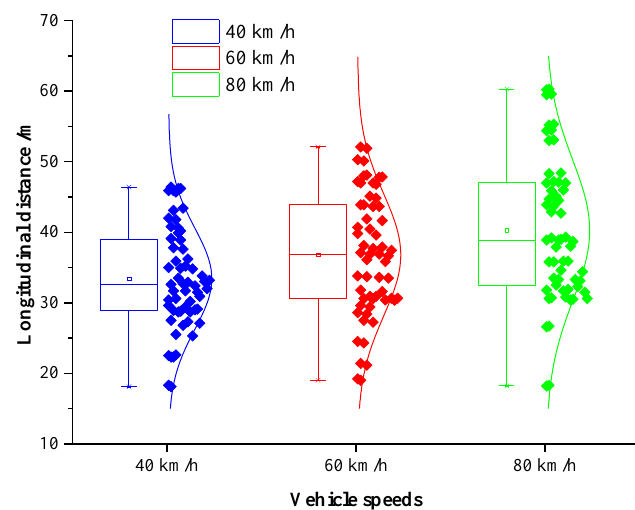
Figure12. Boxdiagramofthelongitudinaldistanceatthebeginningofavoidanceunderdi ff Figure 12. Box diagram of the longitudinal distance at the beginning of avoidance under different speeds.